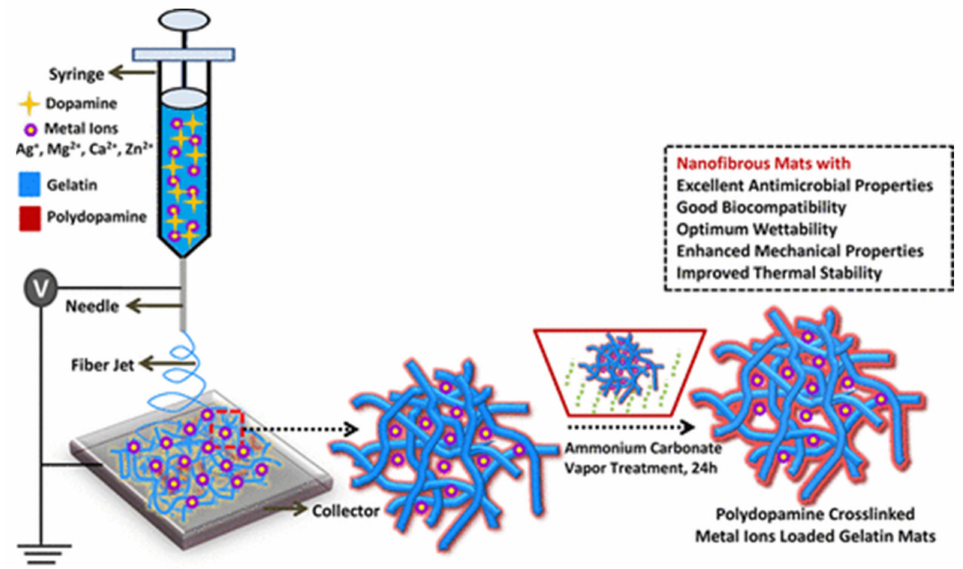
Figure 7. Electrospinning and crosslinking of metal-ion loaded gelatin nanofiber mats. Reprinted with permission from [72]. Copyright 2019 American Chemical